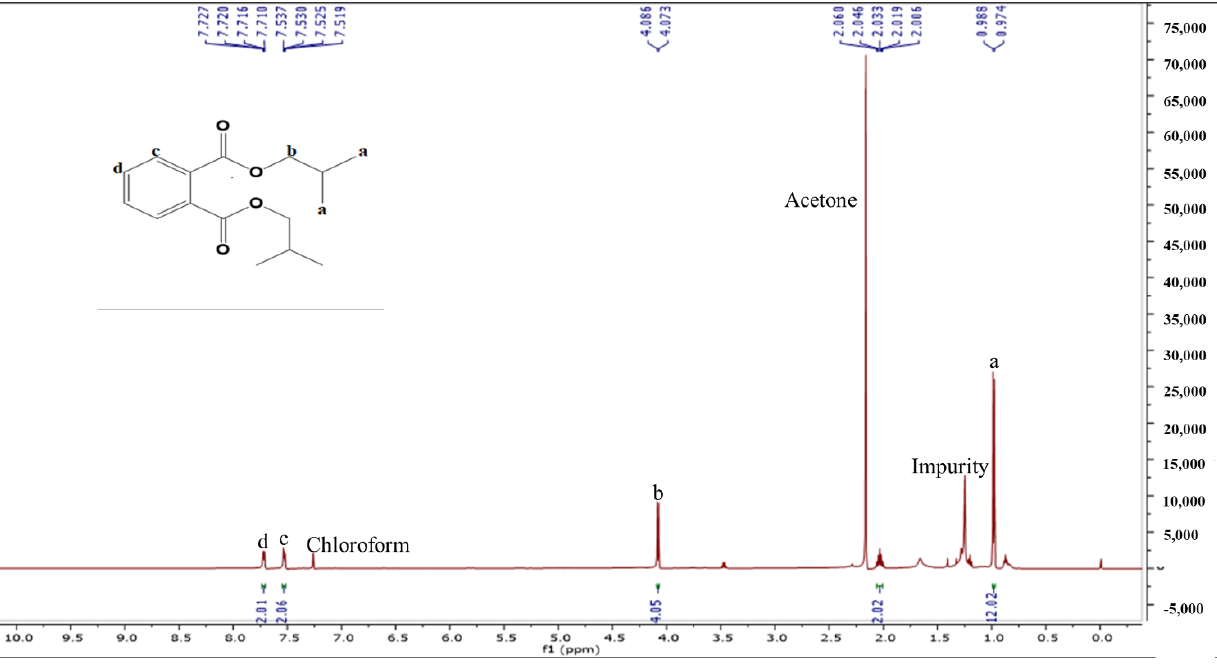
Figure 3. 1 H−NMR of the BDCe fraction from Obea fraction of O. bracteata .